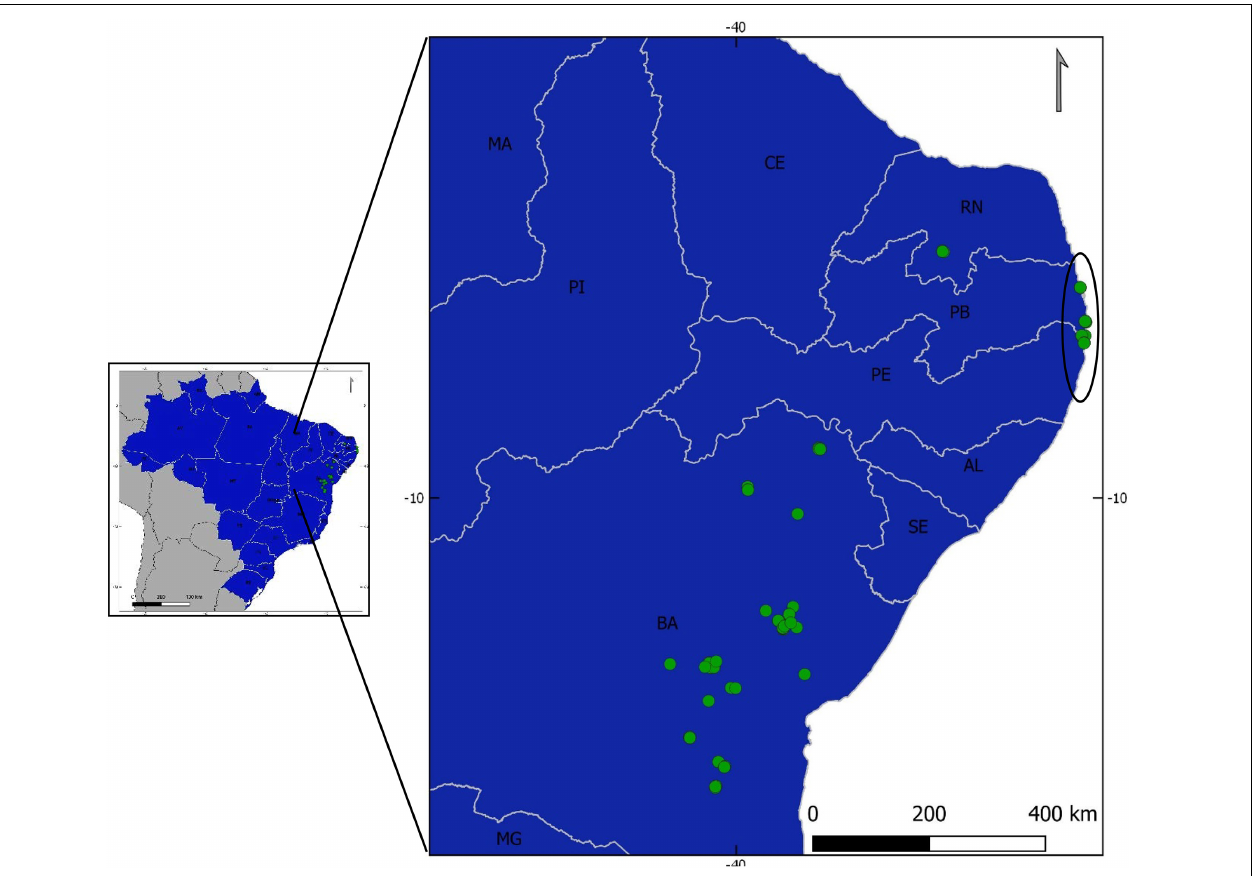
FIGURE 1 | Geographical localization of known populations of Gossypium mustelinum in Brazil, including the populations near the cost of Pernambuco (PE) and Paraiba (PB) states (under circle).